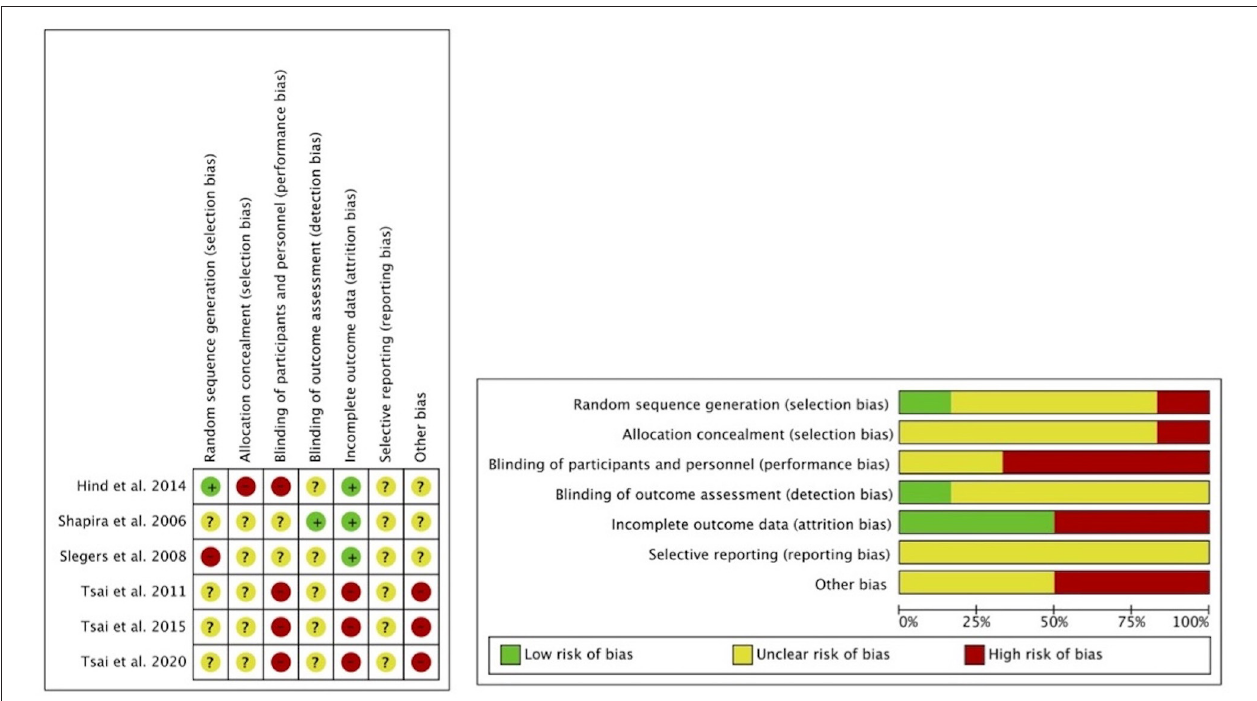
FIGURE 2 | Assessment of risk of bias with selected